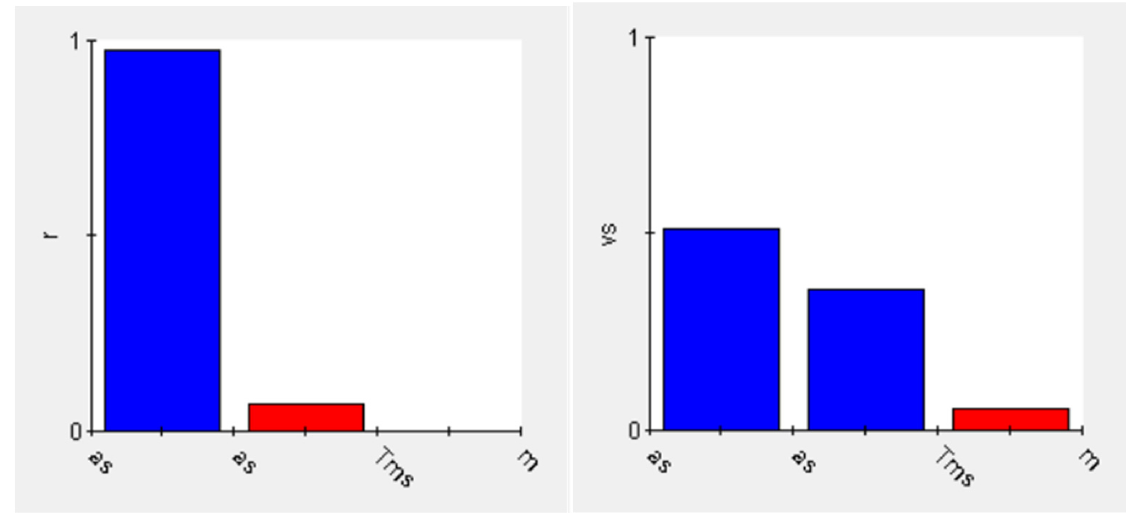
Figure 9. Correlation between shift condition factor and optimum downshifting speed.